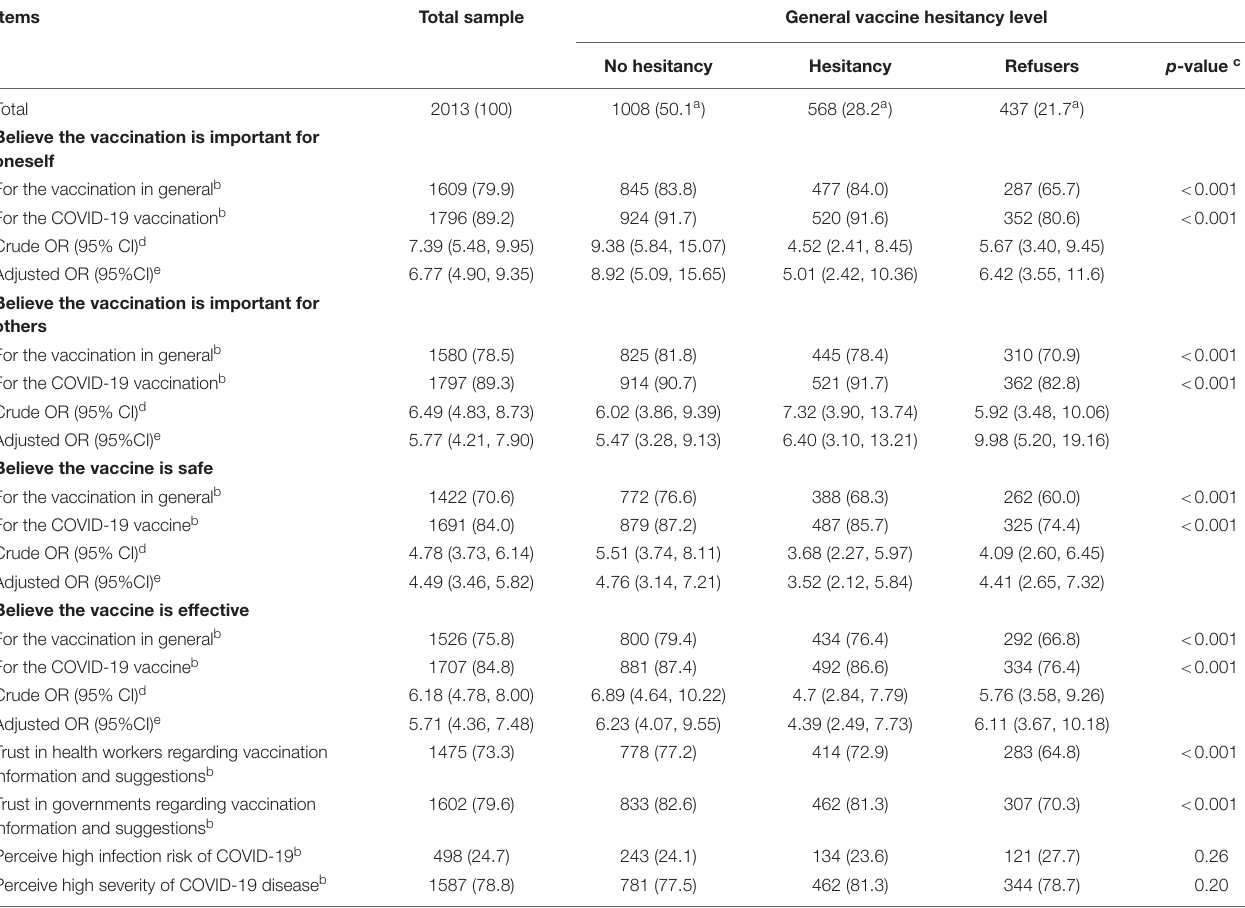
TABLE 2 | Perceptions for vaccination in general and coronavirus disease 2019 (COVID-19) vaccine among participants with different general vaccine hesitancy levels.